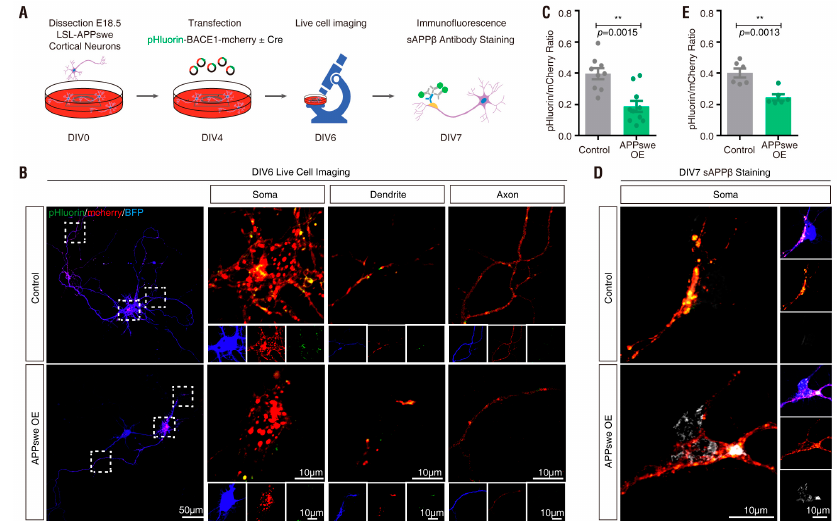
Figure 10. Regulation of pHluorin-BACE1-mCherry and BACE1 activity by Swedish mutant amyloid precursor protein (APPswe) in vitro ( A ) Schematics of live cell imaging experimental procedures. Cortical neurons were dissected from E18.5 LSL-APPswe mice and plated on 35 mm glass-bottom culture dishes at DIV0. Neurons were co-transfected with pHluorin-BACE1-mCherry and BFP without Cre (control) or with Cre (APPswe OE) at DIV4 and underwent live cell imaging at DIV6. Immunostaining of sAPP β was performed at DIV7. ( B ) Confocal live cell imaging of transfected neurons at DIV6 was carried out and representative images are shown. Scale bar, 10 µ m. ( C ) Quantification analysis of the pHluorin / mCherry ratio from ( B ). Data was shown as mean ± SEM ( n > 10 neurons from three independent experiments). Significance was calculated with Student’s t -test; ** p < 0.01. ( D ) Immunostaining of sAPP β in transfected neurons at DIV7 was carried out and representative images are shown. Scale bar, 10 µ m. ( E ) Quantification analysis of the pHluorin / mCherry ratio from ( D ). Data was shown as mean ± SEM ( n > 10 neurons from three independent experiments). Significance was calculated with Student’s t -test; ** p <